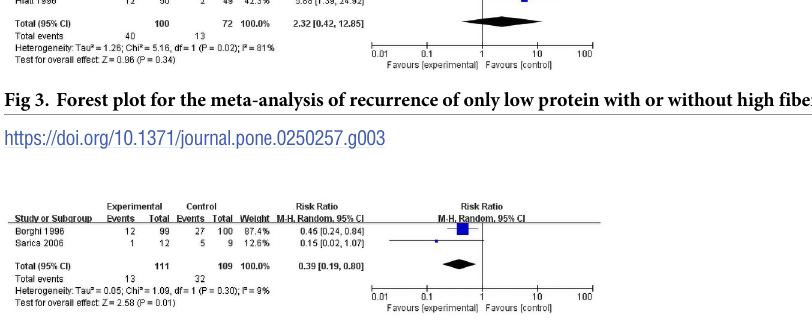
Fig 4. Forest plot for the meta-analysis of recurrence rate of liquid intake.